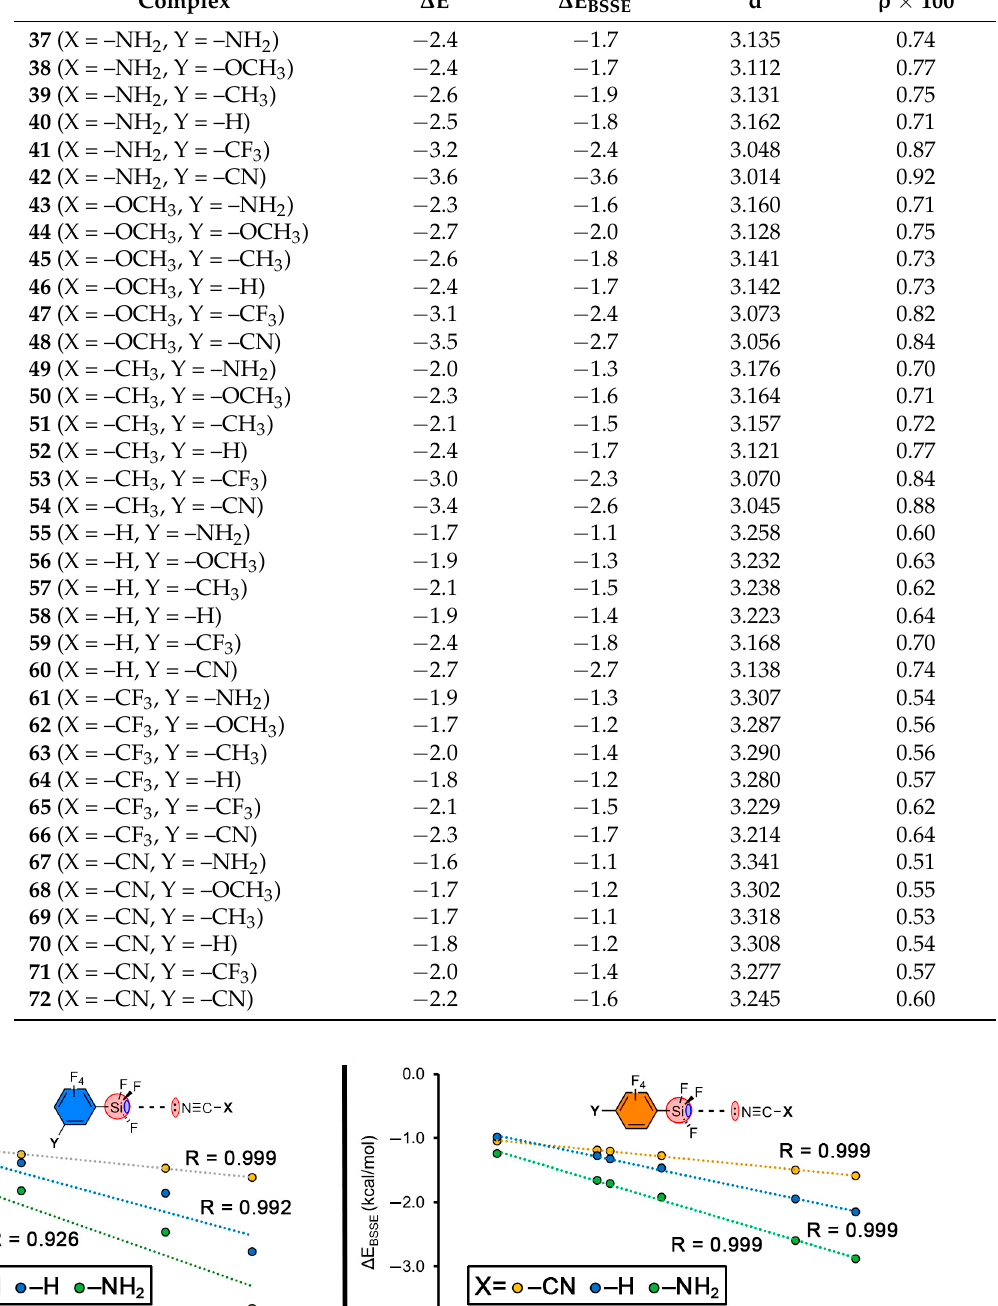
Table 3. Values of the uncorrected and BSSE-corrected interaction energies ( ∆ E and ∆ E BSSE , in kcal/mol), equilibrium distances (d, in Å) and value of the density ( ρ × 100, in a.u.) at the bond critical point (BCP) that characterizes the tetrel bonding interaction in complexes 37 to 72 .